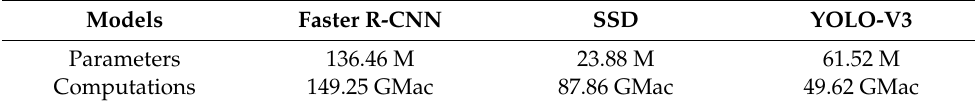
Table 1. Parameters and calculations of different models.